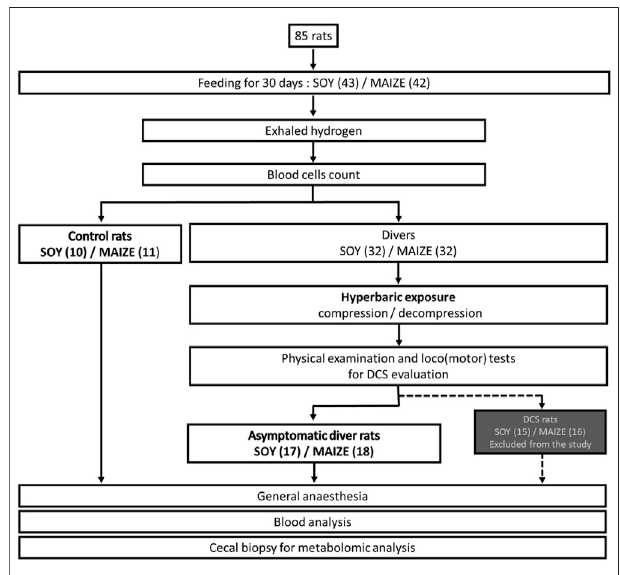
FIGURE 1 | Flow chart